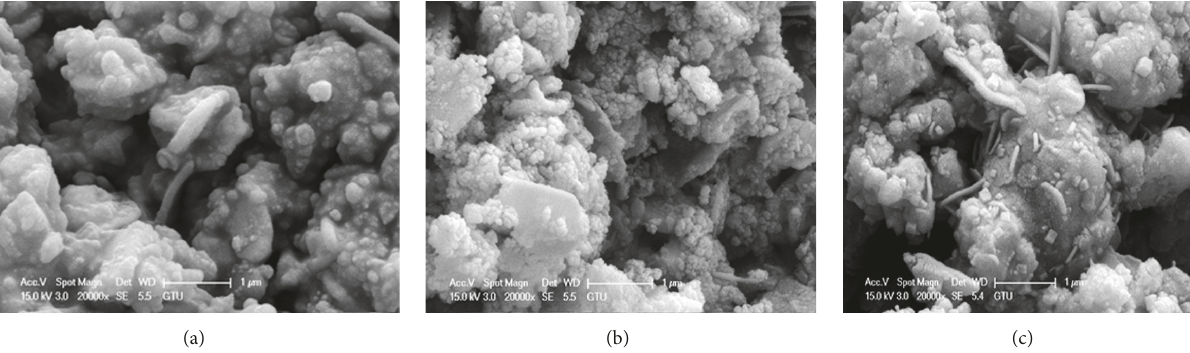
content shifted from Se to Ga during long reaction times.